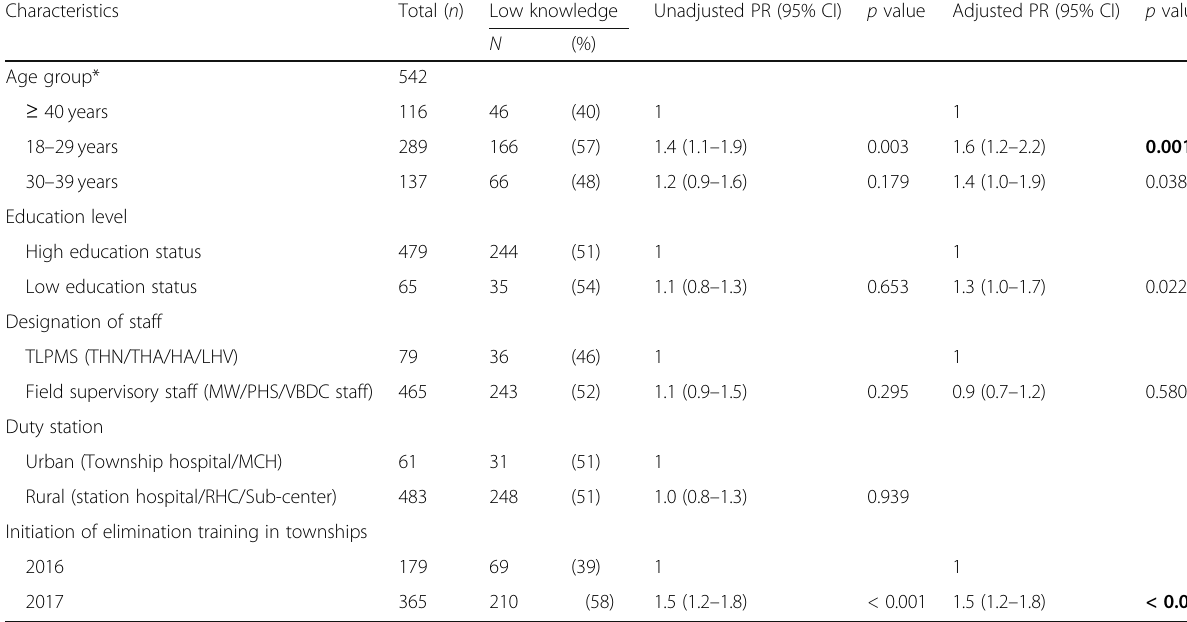
Table 4 Factors associated with knowledge of malaria elimination among the health staff and VBDC teams at six targeted townships for malaria elimination, Myanmar, 2017 to 2018 ( n = 544) Characteristics